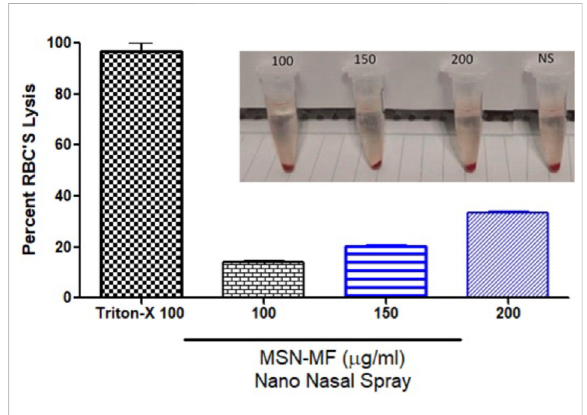
FIGURE 9 Compatibility of the MSN-MF nano-nasal spray with blood.